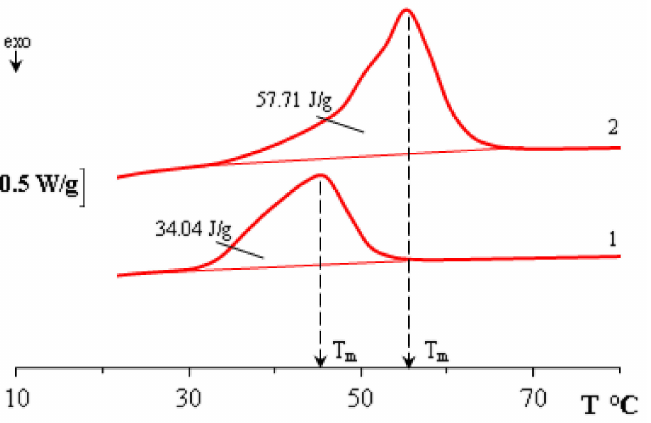
Figure 6. DSC thermogram of mixtures containing PCL (M n = 45 × 10 3 ): 1 – ϕ PCL = 0.38, 2 – ϕ PCL = 0.67.